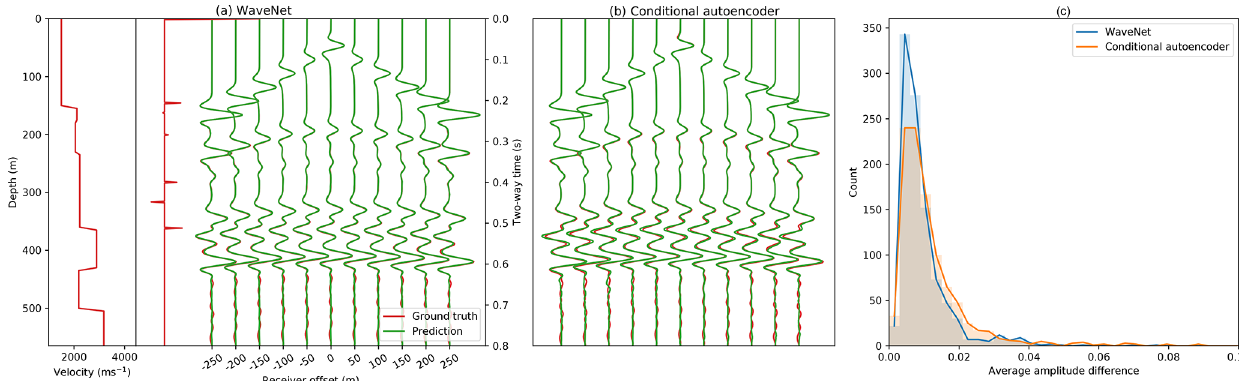
Figure A3. Comparison of WaveNet and conditional autoencoder simulation accuracy. Panel (a) shows a velocity model, reflectivity series and ground truth FD simulation for a randomly selected example in the horizontally layered velocity model test set in red. Green shows the WaveNet simulation. Panel (b) shows the conditional autoencoder simulation for the same velocity model. Panel (c) shows the histogram of the average absolute amplitude difference between the ground truth FD simulation and WaveNet and conditional autoencoder simulations over this test set. A t 2 . 5 gain is applied for